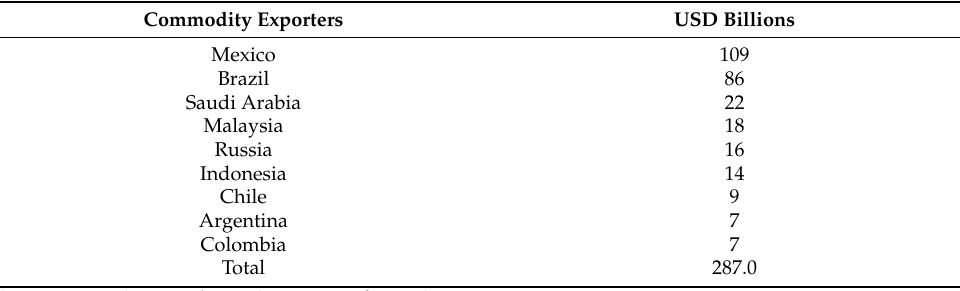
Table 4. U.S. banks’ exposures to EME commodity